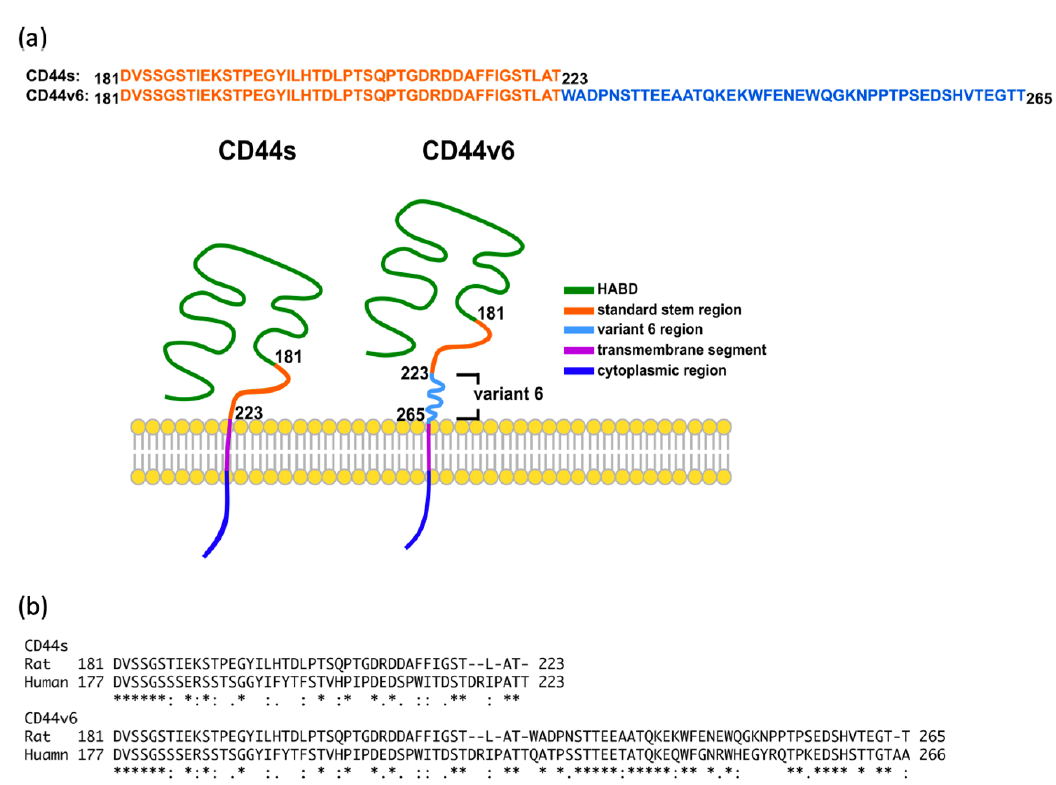
Figure 1. ( a ) Sequence comparison of CD44s and CD44v6 isoform of rat. Di ff erent regions are shown in di ff erent colors. ( b ) Sequence comparison of human and rat. An * (asterisk) indicates positions which have a single, fully conserved residue. A: (colon) indicates conservation between groups of strongly similar properties. A. (period) indicates conservation between groups of weakly similar